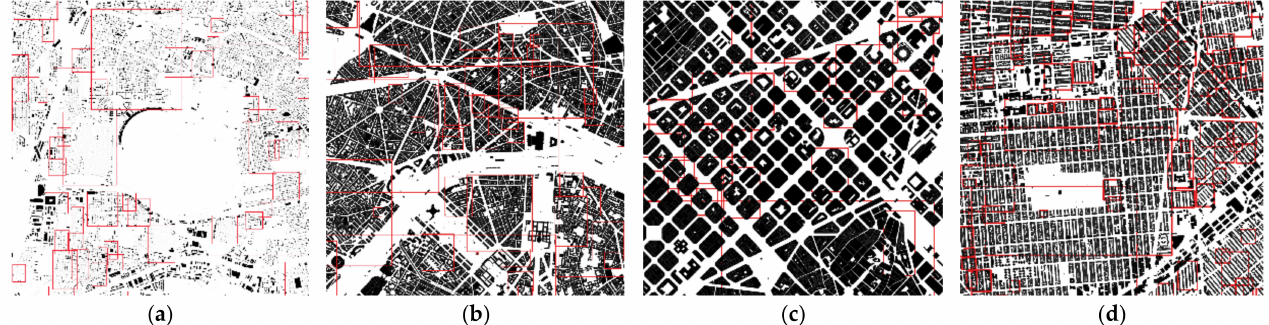
Figure 2. Image datasets of building patterns. ( a ) An example of Germany’s dataset in Berlin, ( b ) Paris’s building pattern, ( c ) Barcelona’s building pattern in the area of interest, and ( d ) the superimposed grid pattern in N.Y.C. in the area of Brooklyn. The red squares represent the clusters’ extents around building